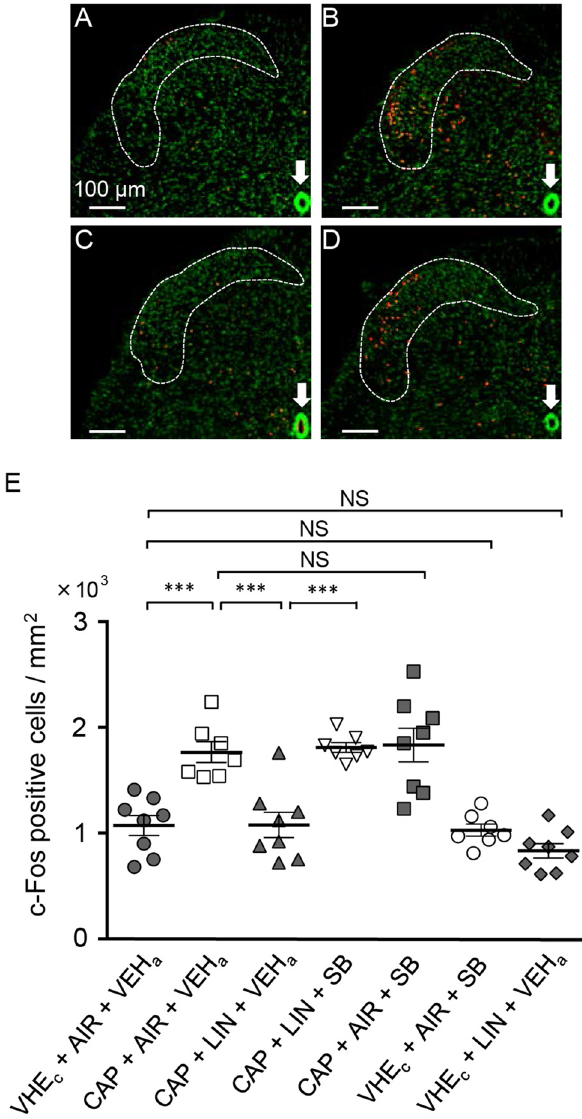
Figure 8. Suppression of capsaicin-induced c-Fos expression in the spinal cord by linalool odor exposure was antagonized by intrathecal orexin 1 receptor antagonist administration. ( A – D ) c-Fos expression in laminae 1 and 2 of the S1 segment (dashed line) are represented at the condition of VEH c + AIR + VEH a ( A ), CAP + AIR + VEH a ( B ), CAP + LIN + VEH a ( C ), and CAP + LIN + SB ( D ). Scale bars in ( A – D ) indicate 100 μm. Arrows in ( A – D ) indicate the Central Canal. ( E ) Densities of c-Fos positive cells in laminae 1 and 2 of the S1 segment after the tail capsaicin test were plotted. AIR; odorless air exposed mice, LIN; linalool odor-exposed mice, VEH c ; mice which received subcutaneous injection of vehicle for capsaicin, CAP; mice which received subcutaneous injection of capsaicin, VEH a ; mice which received intrathecal injection of vehicle for antagonist, SB; mice which received intrathecal injection of 1 nmol OX1 receptor antagonist. Bars represent mean ± SEM. *** p < 0.0005 (Sidak’s multiple comparison